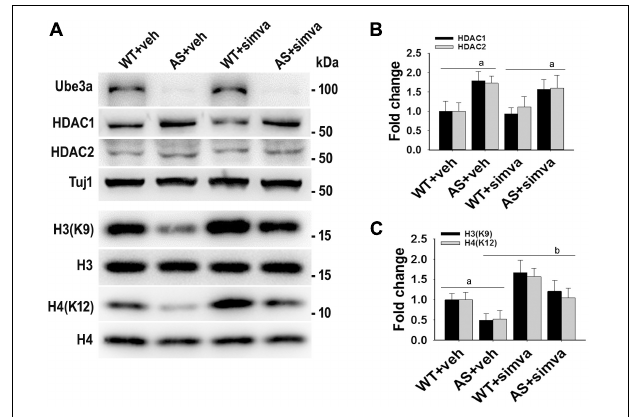
FIGURE 8 | Simvastatin treatment restores acetylation of histones H3(K9)/H4(K12) in cultured primary cortical neurons prepared from AS mice embryo. (A) Mouse cortical primary neurons were cultured from the E16 embryo of time pregnant AS mice and maintained in neuronal maintenance media as described in materials and methods. Fourteen days in vitro (DIV14) neurons were treated with 5 µ M simvastatin for 12 h. Collected cells were then processed for immunoblotting with antibodies against Ube3a, HDAC1/2 and total and acetylated histones H3/H4. (B,C) Band intensities of HDAC1/2 (B) were normalized to Tuj1 (HDAC/Tuj1) while acetylated histones H3/H4 (C) were normalized to their respective total histones (acetylated/total). Values plotted are mean ± SD of three independent experiments. The ‘a’ signify P < 0.05 compared to vehicle or simvastatin treated wild type group while “b” denote P < 0.05 with respect to vehicle treated AS group (one way ANOVA with Holm–Sidak post hoc